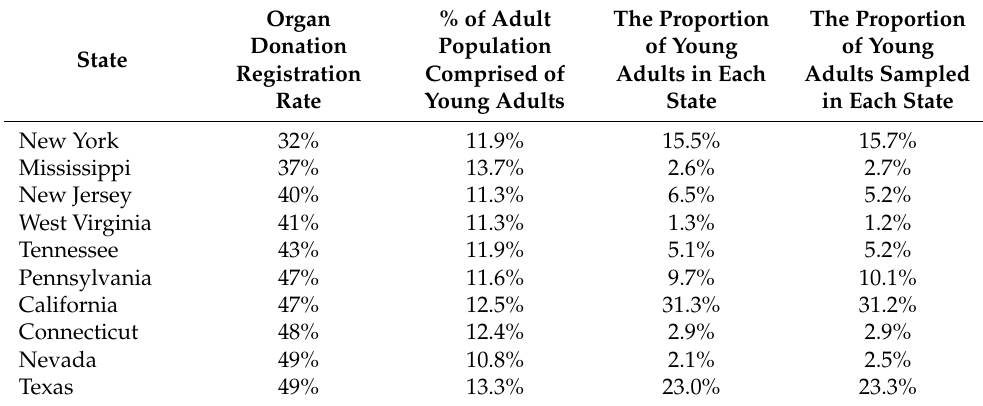
Table 1. The proportion of Young Adults Sampled versus Proportion in the Population of the ten States with the Lowest Rates of Organ Donation in the U.S.